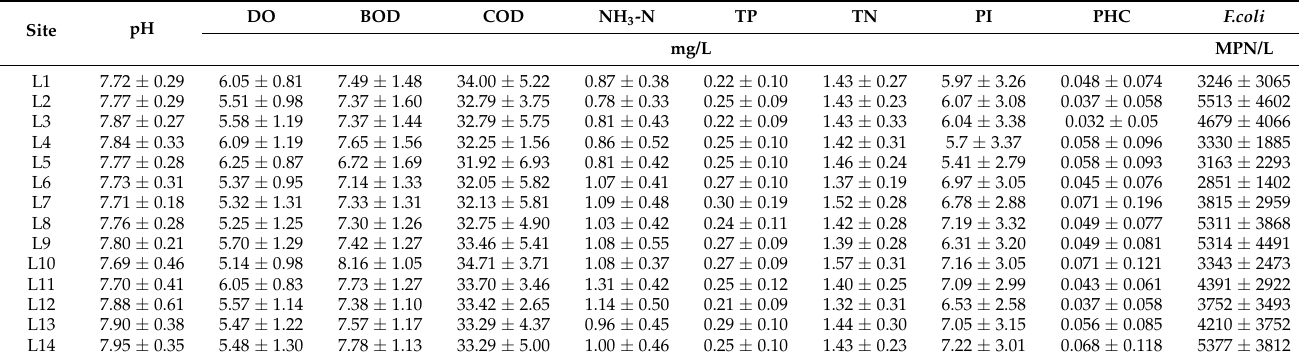
Table 1. Statistical description of water quality indicators in Dongying District during